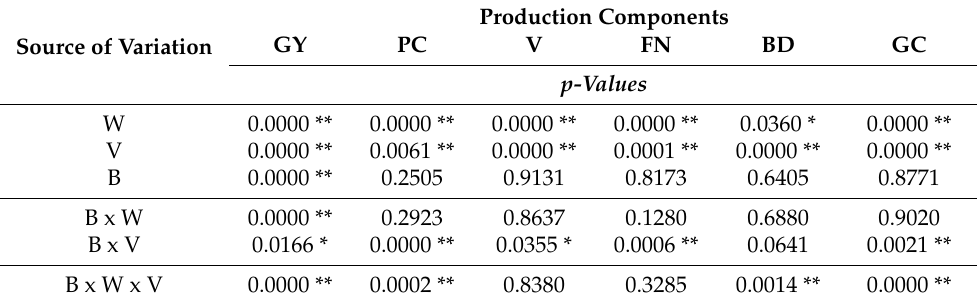
Table 2. Analysis of variance (ANOVA) for impact of different source of variation on production components of durum wheat.